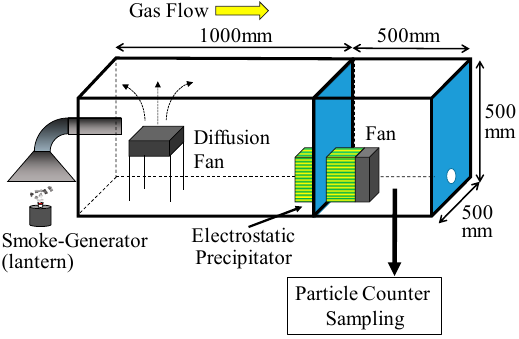
Figure 8. Schematic diagram of the experimental apparatus. An oil lantern was used as the particle generator. The particle concentration was measured downstream of the electrostatic precipitator. Table 3. Average concentrations of particles in various size ranges in the room air and target gas.